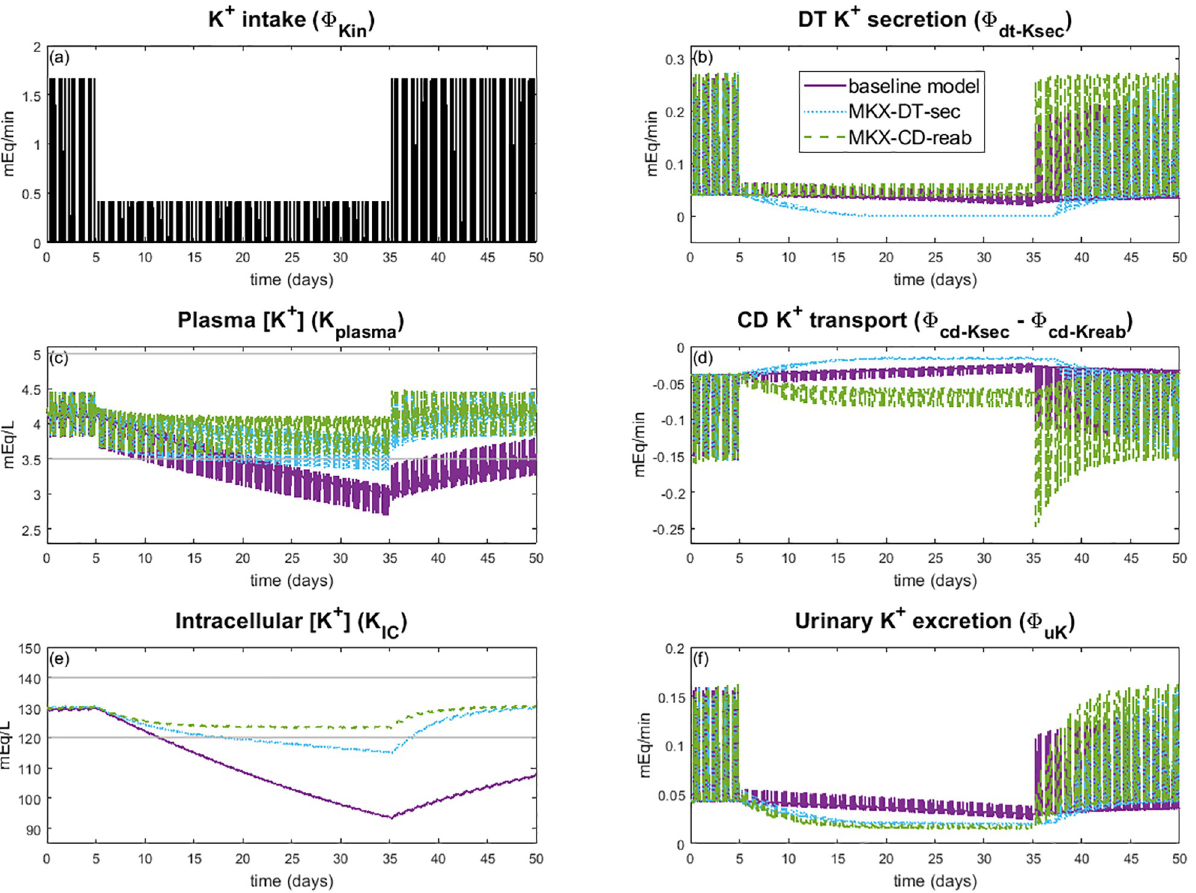
Fig 9. Impact of muscle-kidney cross talk on K + depletion. Simulation results for K + depletion experiments for the baseline model and muscle-kidney cross talk simulations (Case MKX-DT-sec and Case MKX-CD-reab). Potassium intake ( F Kin ) is the same for all three simulation types (A) . Note that Case MKX-CD-sec is not plotted since it had little impact from the baseline model results. Horizontal grey line shows normal range for plasma K + concentration (C) and intracellular K + concentration (E) . CD: collecting duct, DT: distal tubule